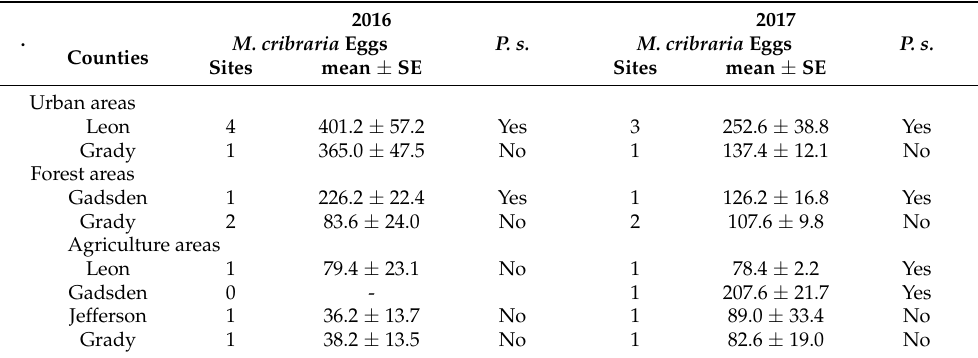
Table 1. Average number of eggs of M. cribraria and presence of P. saccharalis ( P. s .) in urban, forested, and agricultural areas in Leon, Gadsden, Jefferson, and Grady Counties.